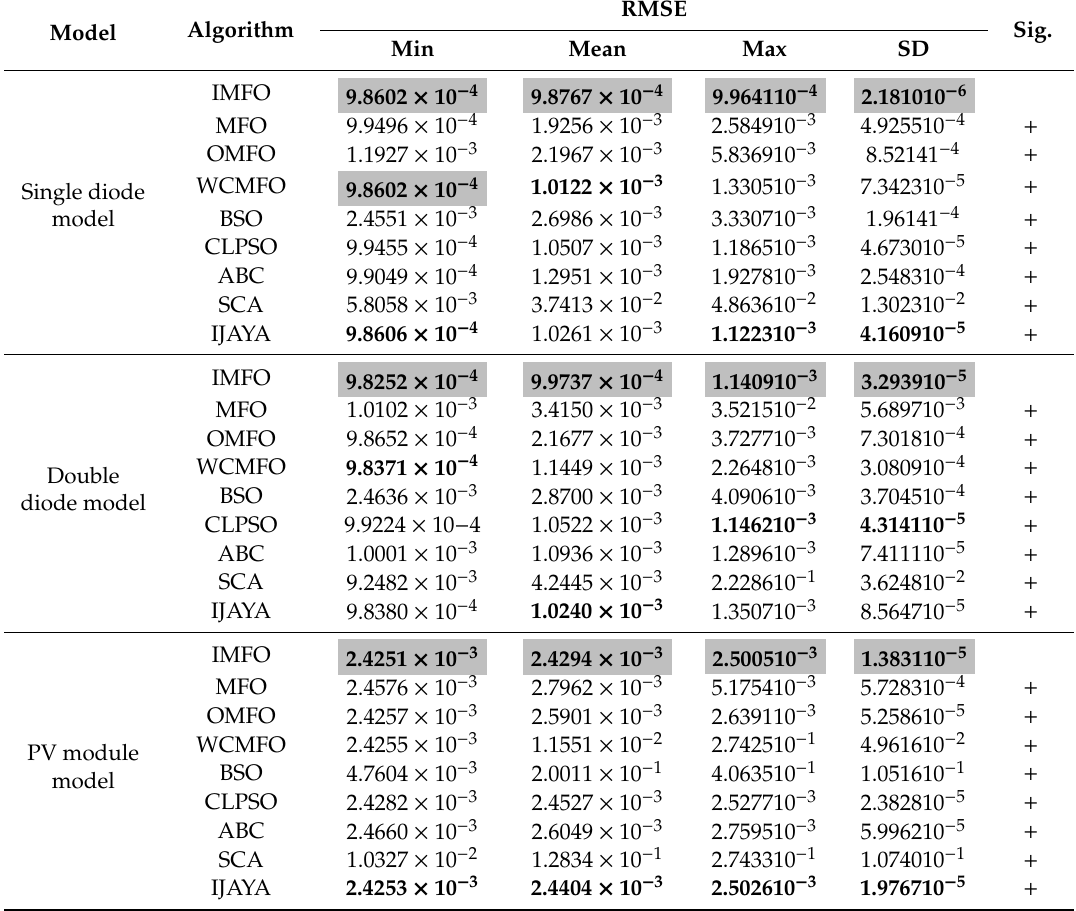
Table 5. Comparisons on the statistical results of di ff erent algorithms for three di ff erent PV